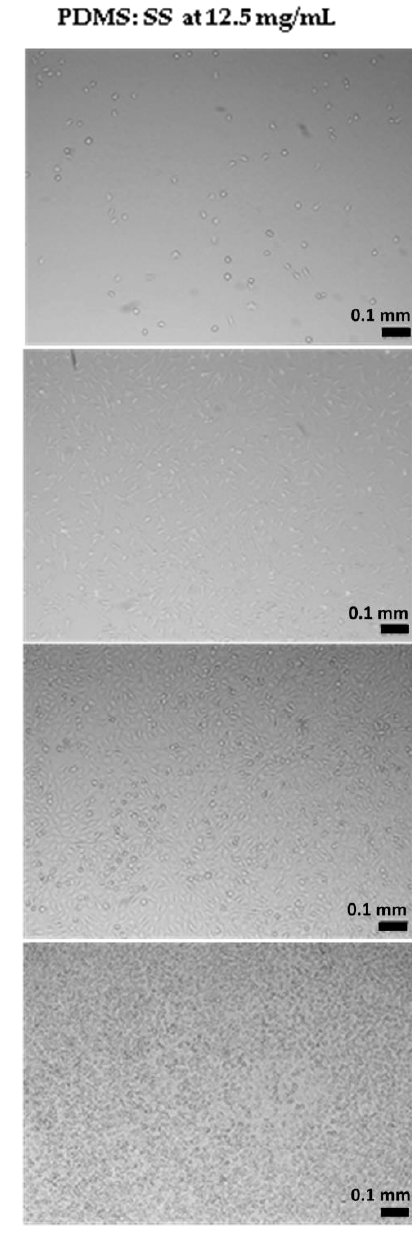
Figure 6. Microscopic images of cells on treatment with PE (negative control) and PDMS: SS coating at 12.5 mg/mL concentration (Taken at 100× magnification with a scale bar of 0.1mm).